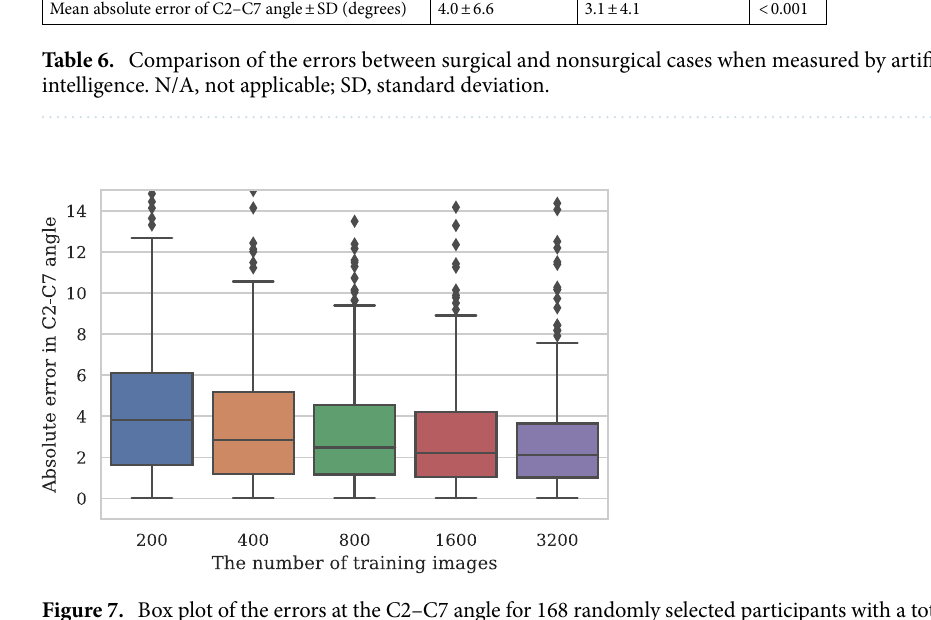
Figure 7. Box plot of the errors at the C2–C7 angle for 168 randomly selected participants with a total of 415 x-rays. The top of the box represents the 75th percentile, the bottom of the box represents the 25th percentile, and the line in the middle represents the 50th percentile. The whiskers represent the highest and lowest values that are not outliers or extreme values. Dots beyond the whiskers represent outliers and extreme